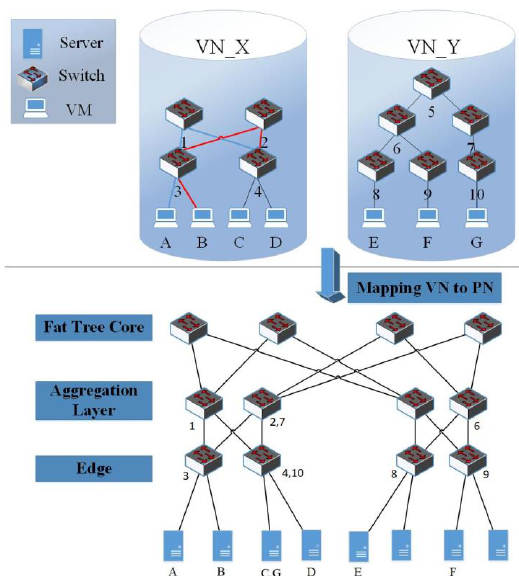
Figure 3. GANA Switch-Centered VN to PN mapping.